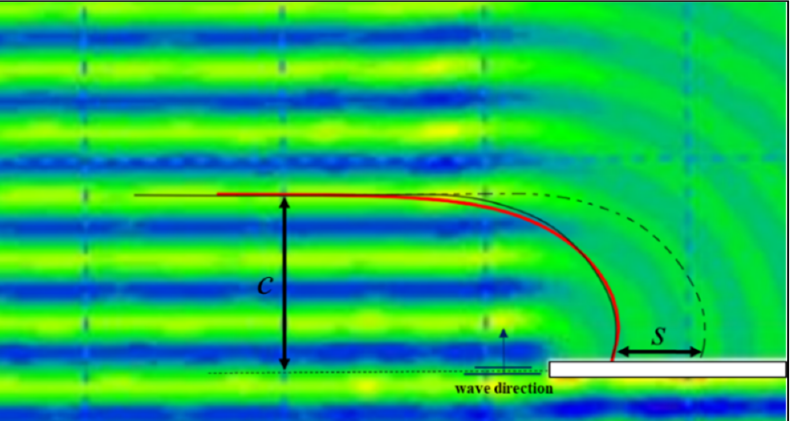
Figure 10. Definition sketch for parameters c (distance between the diffraction point and the asymp- tote of the profile) and s (distance needed to overlap the front on the